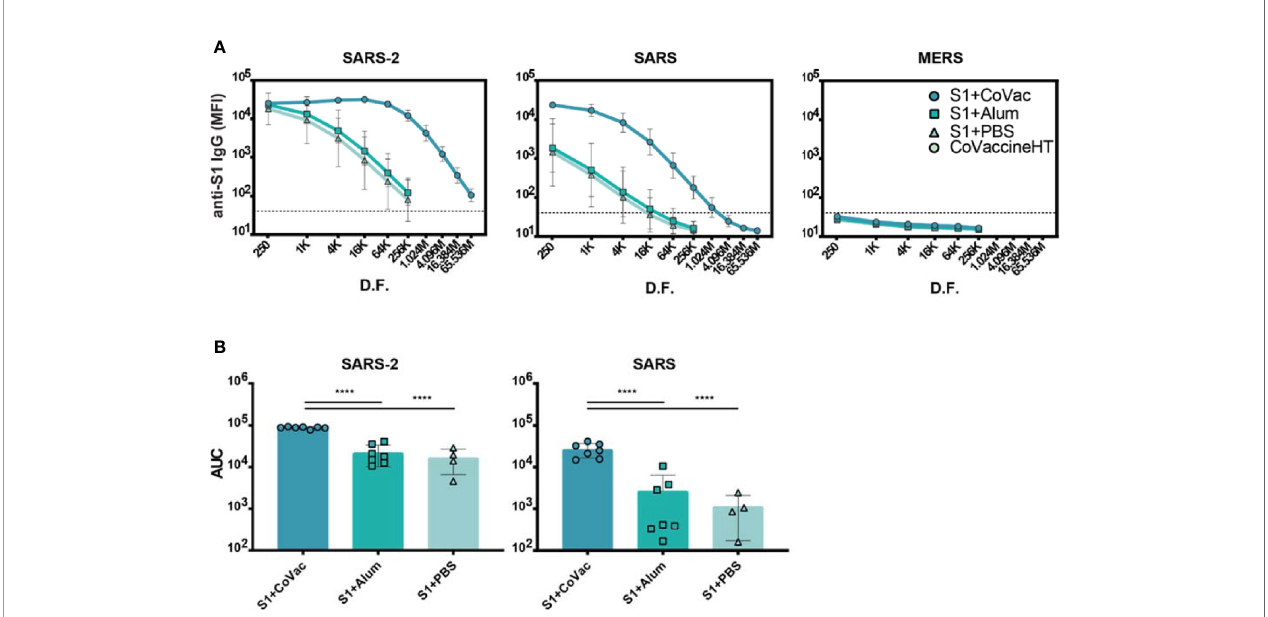
FIGURE 2 | Serum IgG titres against Coronavirus S1 antigens. (A) Antigen reactivity in a four-fold dilution series of mouse sera. (B) Area under the curve (AUC) of data in (A) . Both graphs are in log scale with geometric mean and 95% CI. The dashed lines in (A) represent the cut-off value determined by the mean plus three standard deviations of the negative control (BSA coupled beads). K= x1000, M= x1,000,000, D.F.= dilution factor. Statistics by standard one-way ANOVA. ****p-value <